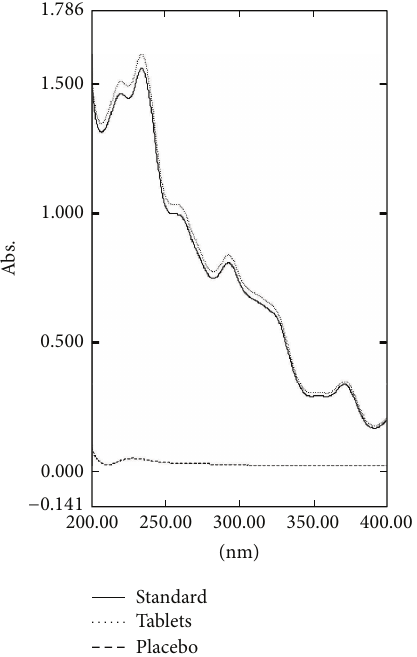
Figure 2: Overlap of standard, tablets, and placebo spectra, in purified water with 20% ethanol at concentration of 22 𝜇 g mL −1 .